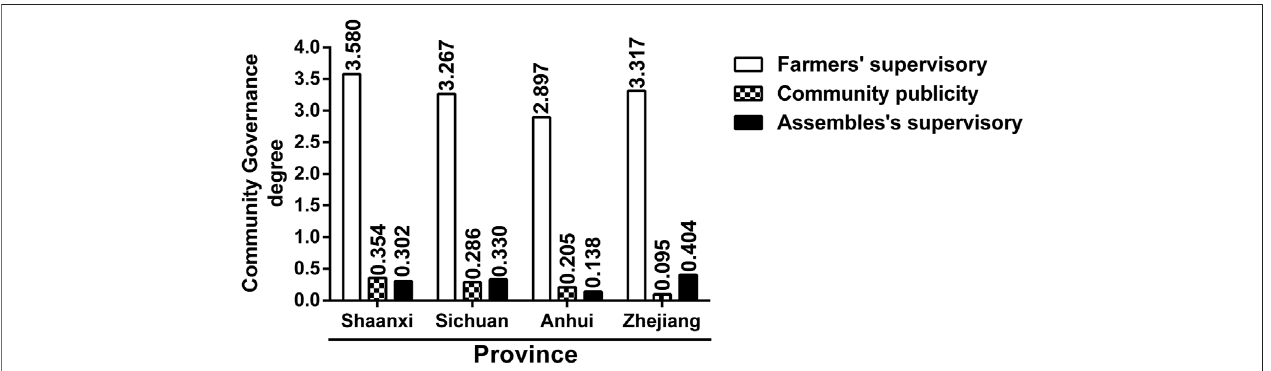
FIGURE 6 | The degree of community governance in different